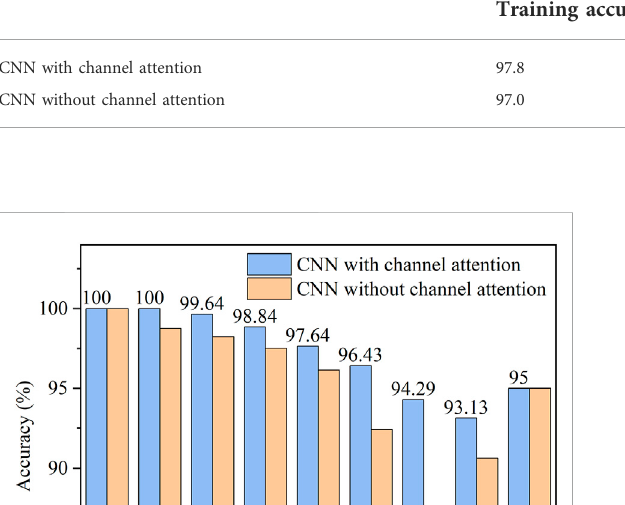
TABLE 4 Training accuracy and validation accuracy of CNN with channel attention and without.